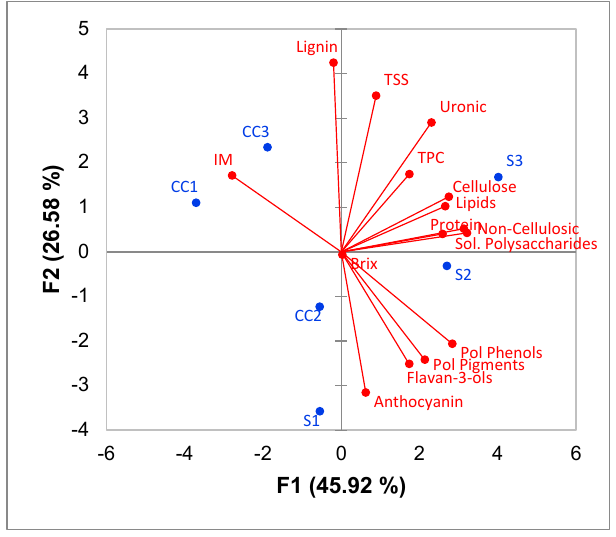
Figure 4. PCA biplot of extraction percentages of the different phenolics analyzed, soluble solid